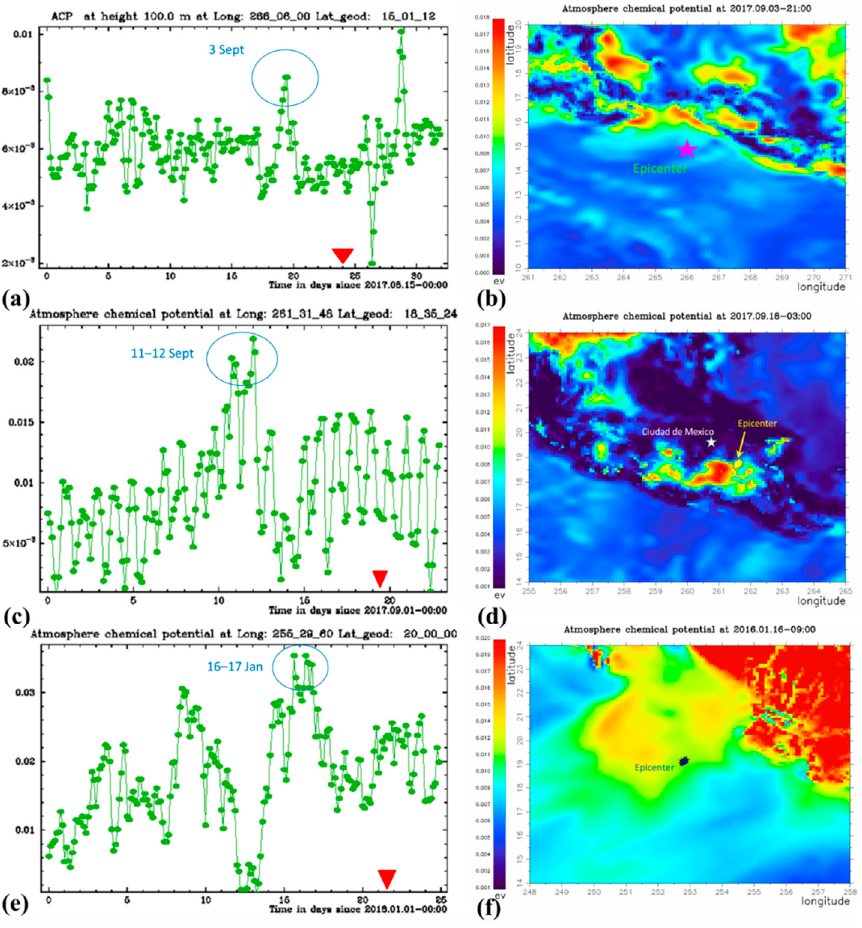
Figure 14. Temporal (left panels, ( a,c , e )) and spatial (right panels, ( b , d , f )) ACP variations few days before and after the 3 selected earthquakes in Mexico (8.2 Mw on 8 September 2017-upper panels, 7.1 Mw on 19 September 2017-middle panels and 6.6 Mw on 21 January 2016 -lower panels). Red triangles indicate the earthquake occurrence time. Blue circles denote ACP anomalies (increase) prior to each earthquake.